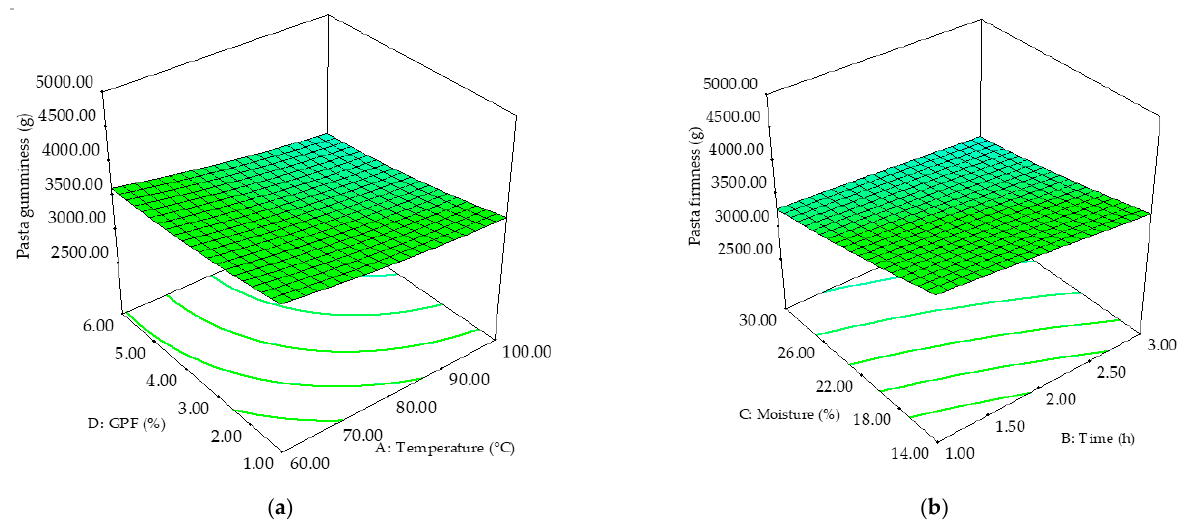
Figure 8. Three-dimensional response surface plots presenting the synergistic effects of factors: GPF level–temperature ( a ) and moisture-time ( b ) on pasta gumminess.